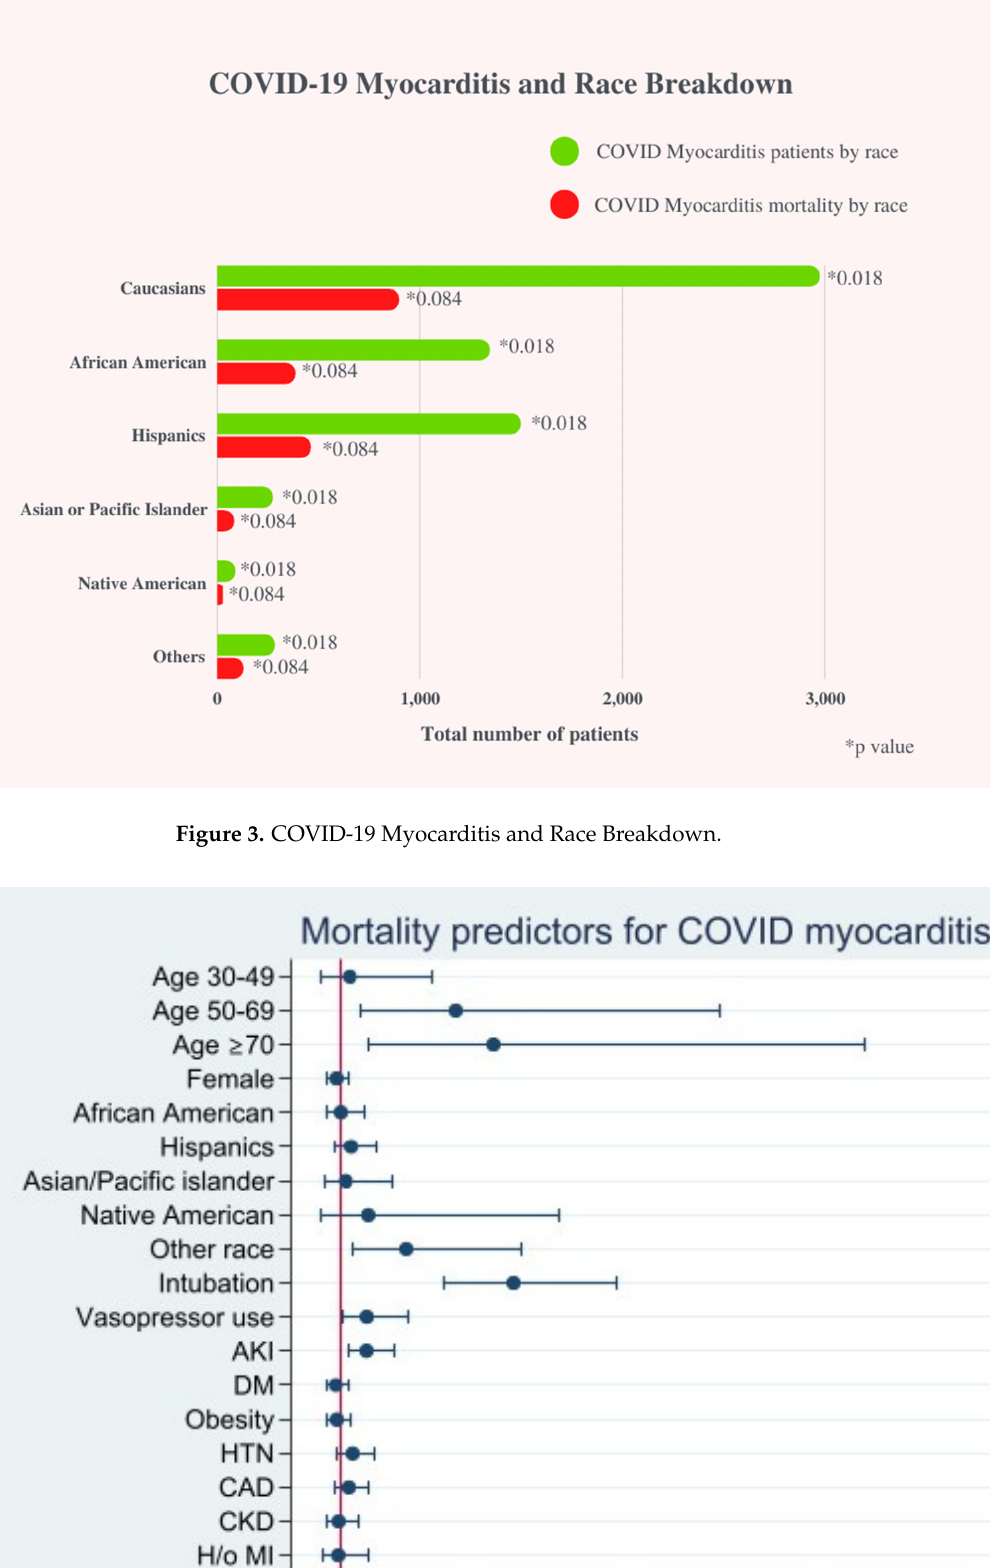
Figure 4. Mortality Predictors for COVID 19 Myocarditis.